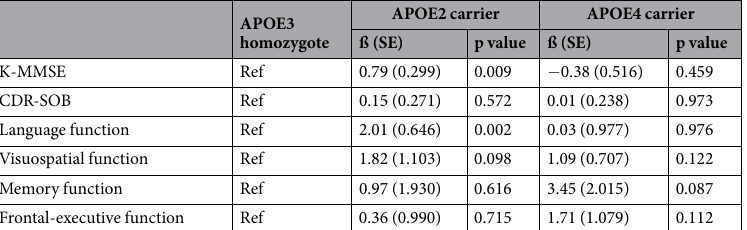
Table 3. Relationships between APOE genotype and longitudinal changes in cognitive function Generalized estimating equation with linear model conducted with cognitive function as the dependent variables and APOE genotype as the independent variables after controlling for age, gender, and education. APOE = apolipoprotein E; β = unstandardized beta coefficient; SE = standard error; Ref = reference; K-MMSE = Korean version of mini-mental state examination; CDR-SOB = clinical dementia rating-sum of